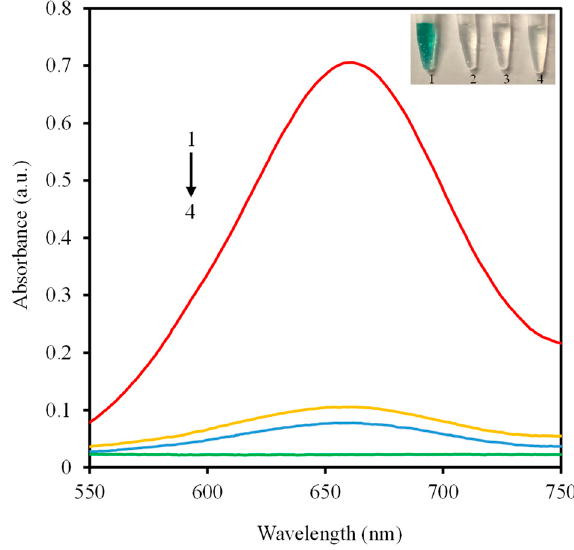
Figure 2 . UV-Vis absorption spectra and digital photograph of VB6-TMB-H 2 O 2 (1), VB6-TMB (2), TMB-H 2 O 2 (3) and VB6-H 2 O 2 (4).